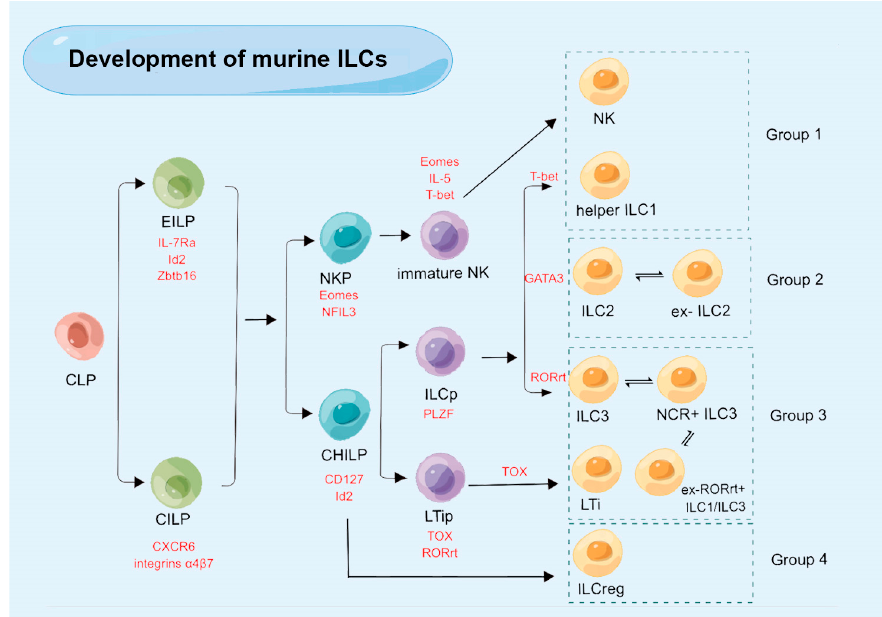
Figure 1. The development of murine innate lymphoid cells (ILCs). CLP: common lymphoid progenitor; EILP: early innate lymphoid progenitor; CILP: common ILC precursor; CHILP: common helper ILC progenitor; NKP: natural killer progenitor; ILCp: ILC precursor; LTip: lymphoid tissue inducer precursor; LT: lymphoid tissue inducer; ILCreg: regulatory ILC. In human, early tonsillar progenitors (ETPs), which were once referred to as stage 1 and stage 2 NK cell developmental intermediates (NKDIs) and are currently detected in secondary lymphoid tissues (SLTs), are the earliest ILC progenitors that have been identified. Specific classifications of ETPs include Lin − CD34 + CD10 + CD117 − ETP1 and Lin-CD34 + CD10 − CD117 + ETP2 [33]. The expression of IL-1R1 is variable in ETP2s. IL-1R1+ ETP2s are ILC-restricted, characterized as ID2 + ROR γ t + RAG1, while IL-1R1 − ETP2s show some T-cell and DC potential [41]. IL-1R1 + ETP2s are the earliest committed human CILCP which has the phenotypic characteristics of a Lin − CD34 − CD7 + CD127 + CD117 + CRTH2 − ILC progenitor (ILCp) [42]. The expression of NKp46, CD56, and killer cell lectin-like receptor subfamily G member 1 (KLRG1) can be used to distinguish between several ILCp